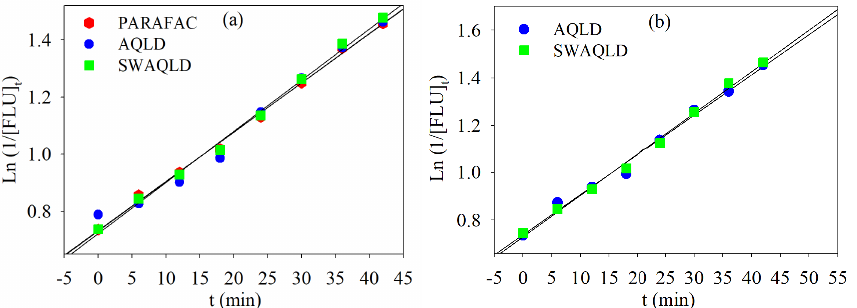
Figure 7. The plot of the natural logarithm of reciprocal of relative concentration (Ln(1/[FLU] t )) versus time (t) for PARAFAC, AQLD, and SWAQLD in the case of wastewater samples and a rank of 3 ( a ) or 4 ( b ). Table 7. Regression equation, correlation coefficient, rate constant, and half-life of the oxidation reaction of FLU in wastewater samples. Regression